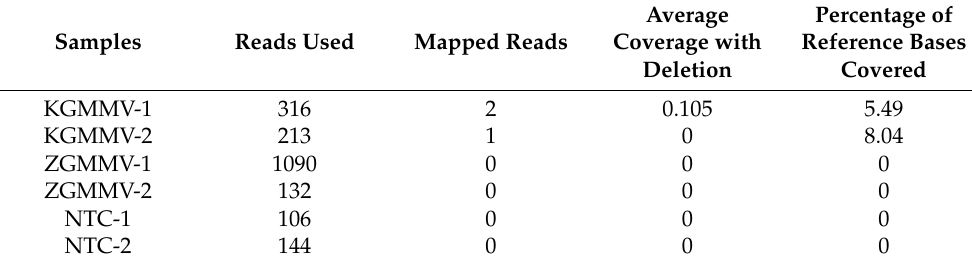
Table 4. Kyuri green mottle mosaic virus (KGMMV) Part Number LPC 65001 and zucchini green mottle mosaic virus (ZGMMV) Control No. Adg/080716/20 positive controls were tested in duplicate by tiled amplicon nanopore sequencing. Data is presented for the number of sequence reads generated for each sample after quality and length trimming, number of reads mapping to the 6377 nt reference CGMMV sequence (GenBank Accession KY115174.1), percentage (%) of CGMMV reference sequence bases covered, and average number of reads at each reference base (Average read